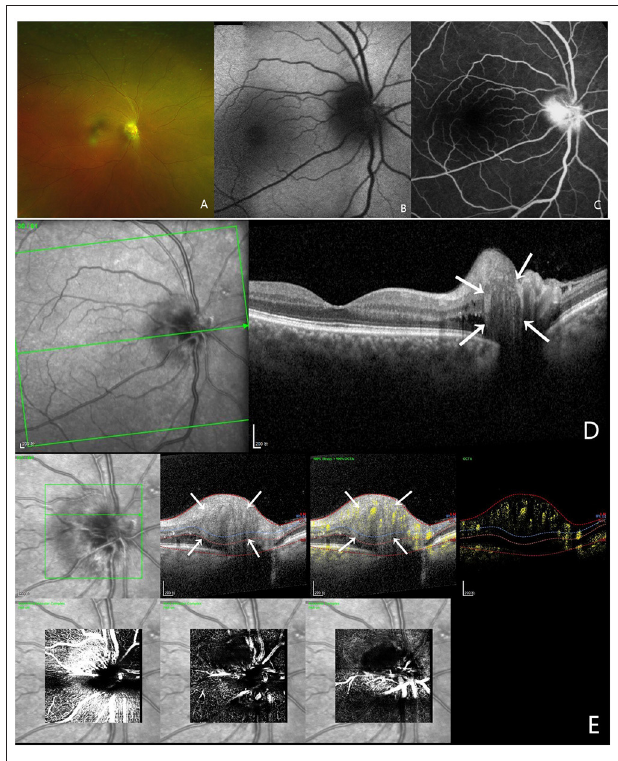
FIGURE 1 | Multi-modal image data of case 1. (A) Color fundus photography showed blurred boundaries and bleeding of the optic disc. (B) This case did not show autofluorescence. (C) FFA shows a hyperreflective optic disc with poorly defined boundaries. (D) OCT confirmed the presence of PHOMS, which is a hyperreflective ovoid mass-like structure surrounded by a hyporeflective edge around the optic disc. (E) OCTA showed a vascular complex, and there was a strong blood flow signal within this hyperreflective